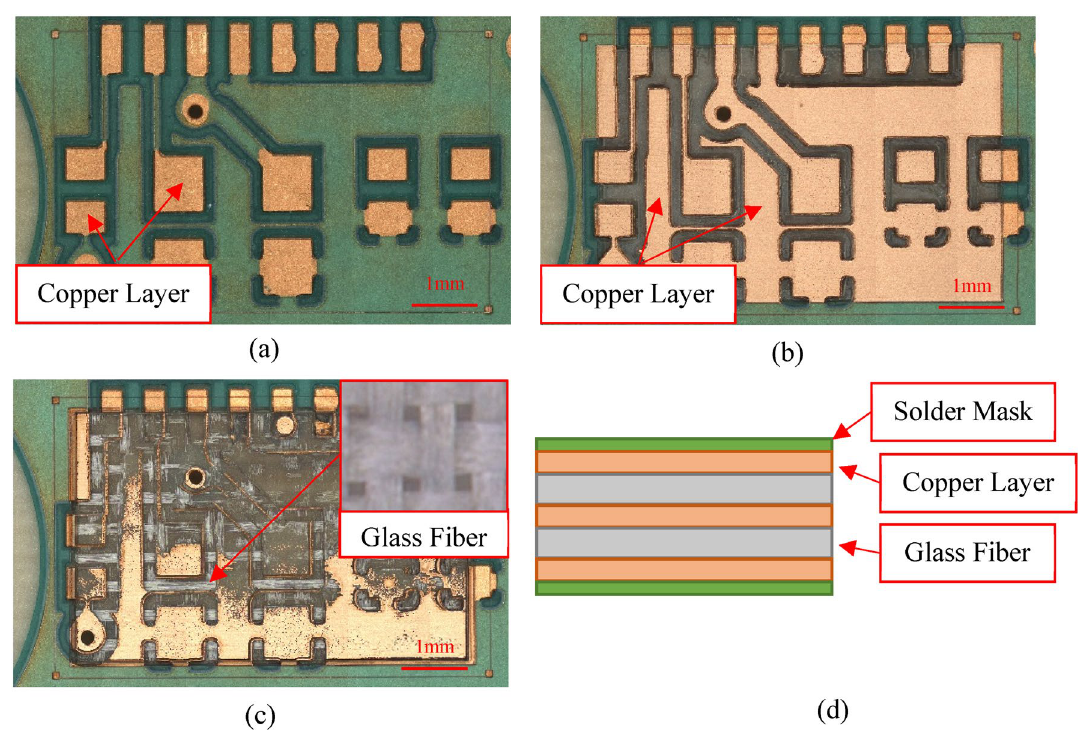
Figure 4. Digital image of the PCB board after: ( a ) 0 cycles of lasering; ( b ) few cycles of lasering; and ( c ) tens of cycles of lasering. ( d ) Schematic illustration of PCB cross